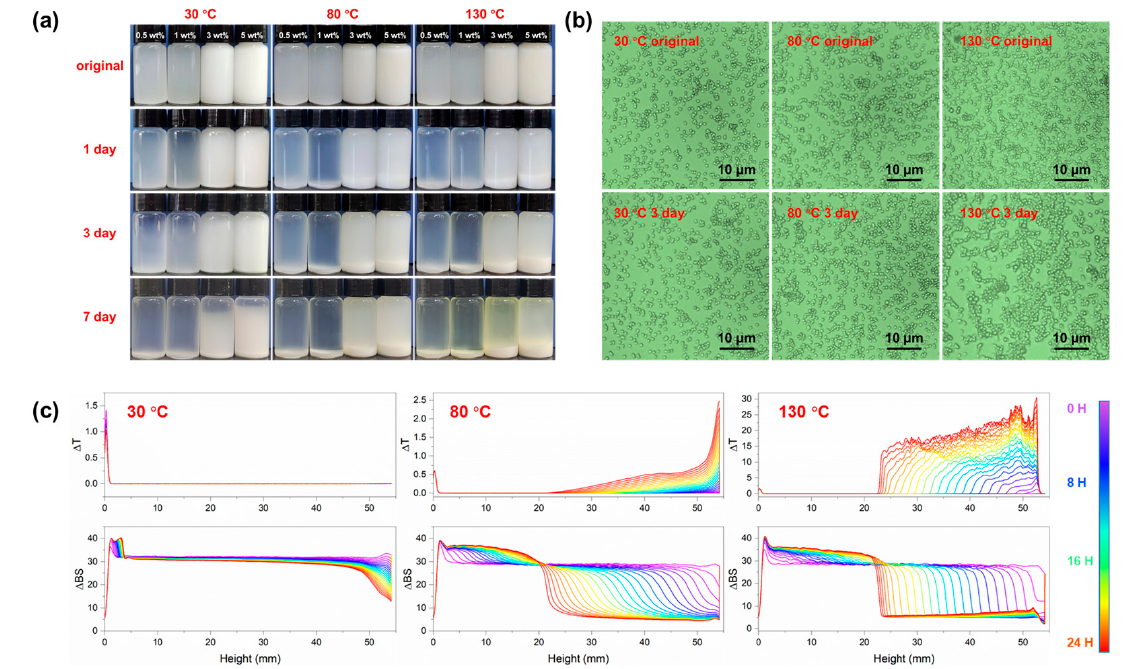
Figure 2. ( a ) Photographs of mineral oil dispersions with different concentration of PSL rubber nanogels at various temperature captured on different storage days (specified at the left, up to 7 days). ( b ) Optical microscope images of mineral oil dispersions with 5 wt% PSL rubber nanogels at various temperature for 3 days. Before observation, the dispersion was diluted 50 times using mineral oil. ( c ) NIR transmittance ( ∆ T) and backscattering ( ∆ BS) results for the mineral oil dispersions with 5 wt% PSL rubber nanogels at various temperatures obtained every 30 min for 12 h (the color of each curve represents its measurement time, as denoted in the spectral column on the right). The x-axis indicates the sample height from 0 (bottom) to 55 mm (top).